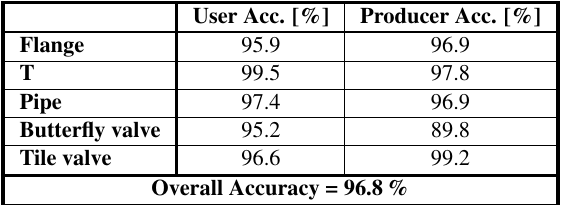
Table 1: User Accuracy and Producer Accuracy obtained on each class and Overall accuracy on images.